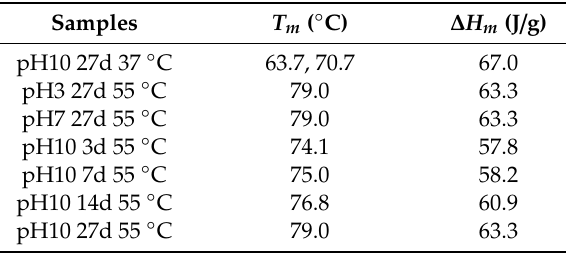
Table 1. Melting peak temperatures and enthalpies of P4HB sutures degraded at the indicated pH values, temperatures, and exposure